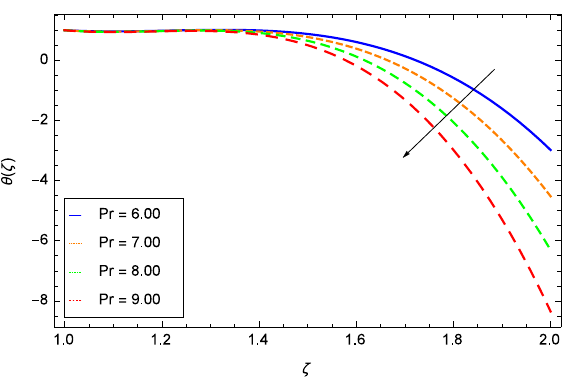
Figure 12. Non-dimensional temperature θ ( ζ ) sketch for h = − 1.10, β 1 = 1.10, M = 0.10, φ = 0.04, Re = 0.70 and various values of Pr (CuO-H 2